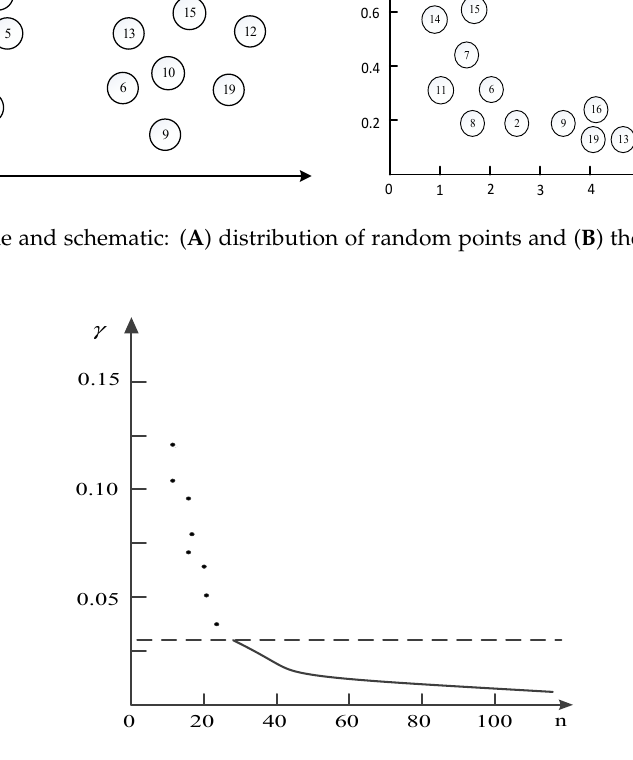
Figure 9. γ value descending arrangement of the schematic.